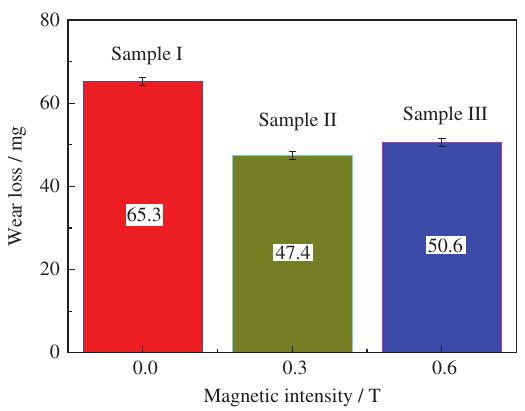
Figure 7: Relationship between the weight loss of Ni-TiN composite